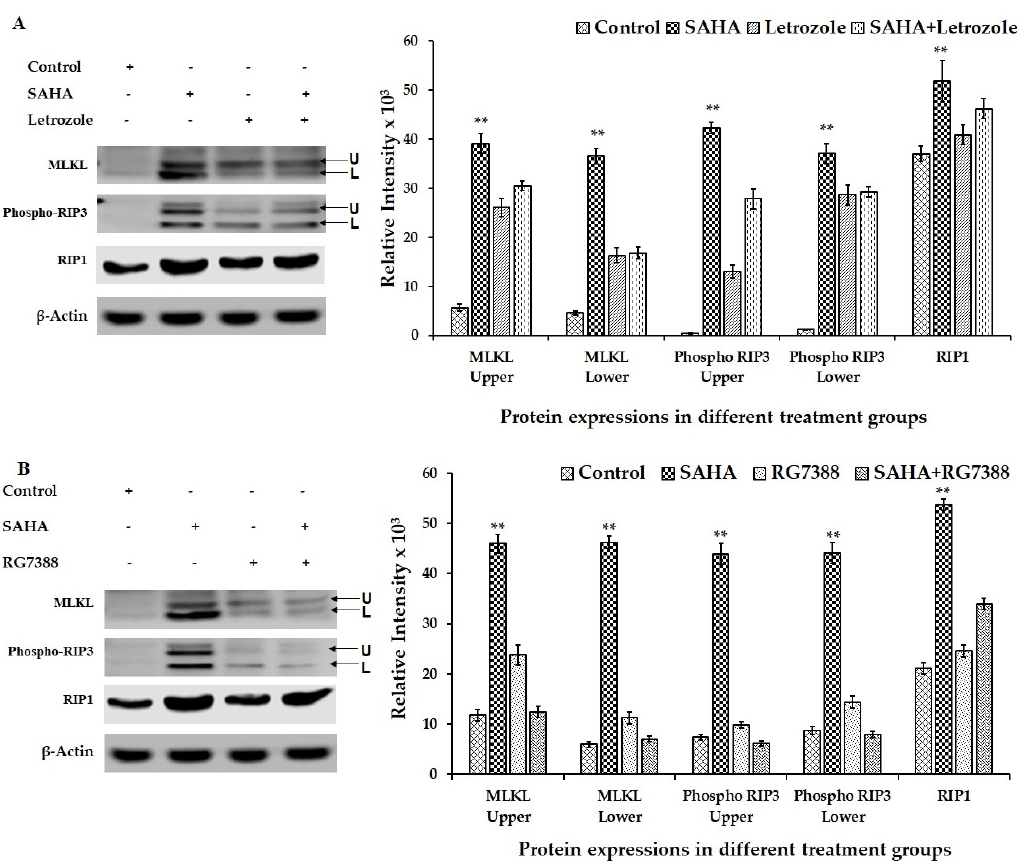
Figure 8. Representative western blot images showing the changes in the levels of necroptosis-related proteins in MCF-7 cells after SAHA, letrozole RG7388 and combination treatments. ( A ) Modulation in the levels of necroptosis-related gene proteins such as MLKL, phospho-RIP3, and RIP1 in MCF-7 cells treated with SAHA (7.5 µ M), letrozole (100 nM) and SAHA + letrozole for 24 h. ( B ) Modulation of necroptosis-related protein expressions in MCF-7 cells after SAHA (7.5 µ M), RG7388 (2.0 µ M) and SAHA + RG7388 treatment for 24 h. The right panel represents the band intensity of apoptosis proteins normalized to that of β -actin by ImageJ software. Data are presented as means ± SD from minimum of three independent experiments. The level of significance is indicated as ** p < 0.01 compared to control.